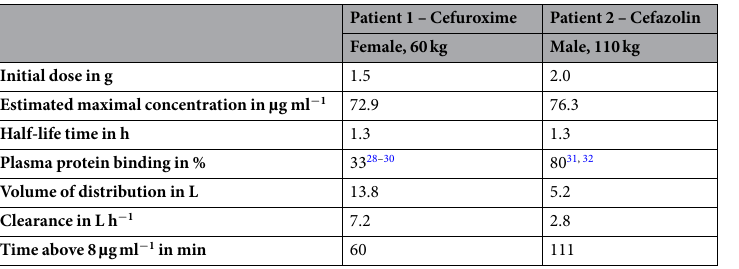
Table 2. Calculated pharmacokinetic parameters of patient 1 and